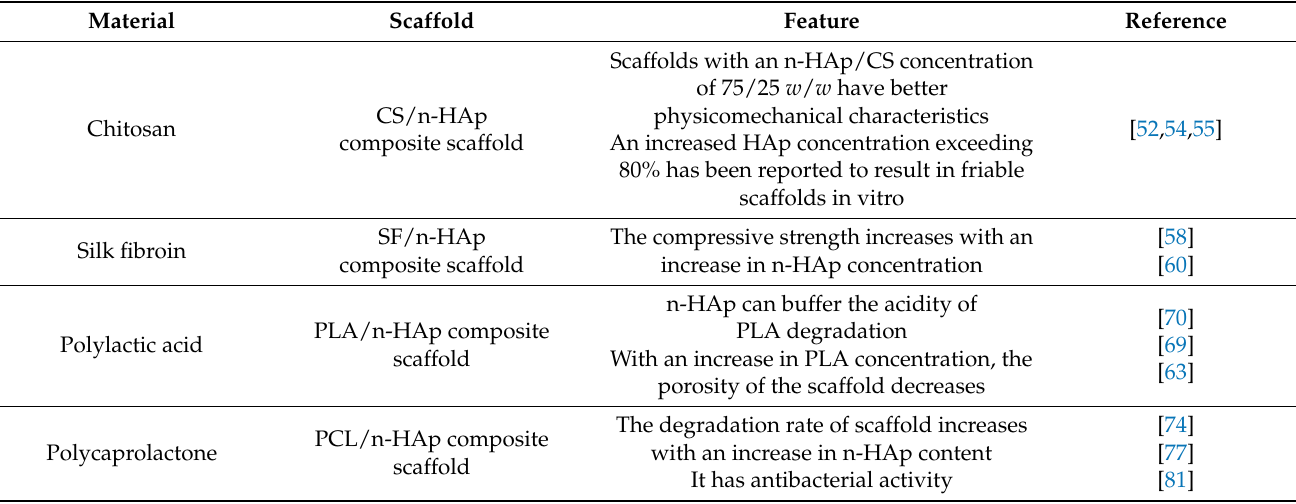
Table 1. Summary of n-HAp composite scaffolds for bone